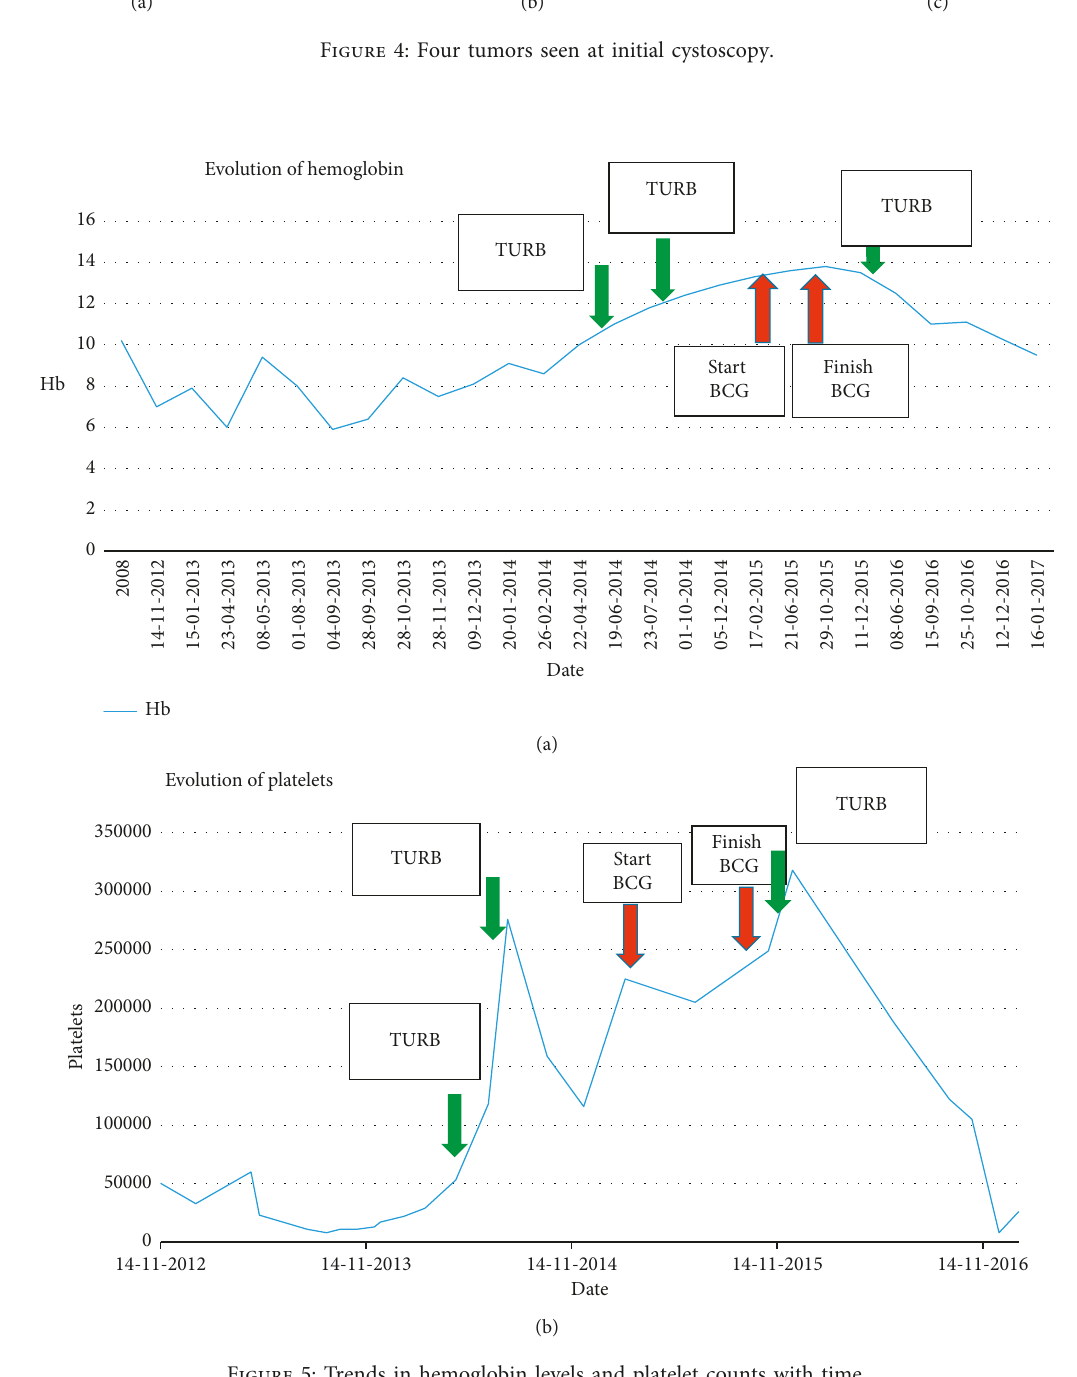
Figure 5: Trends in hemoglobin levels and platelet counts with